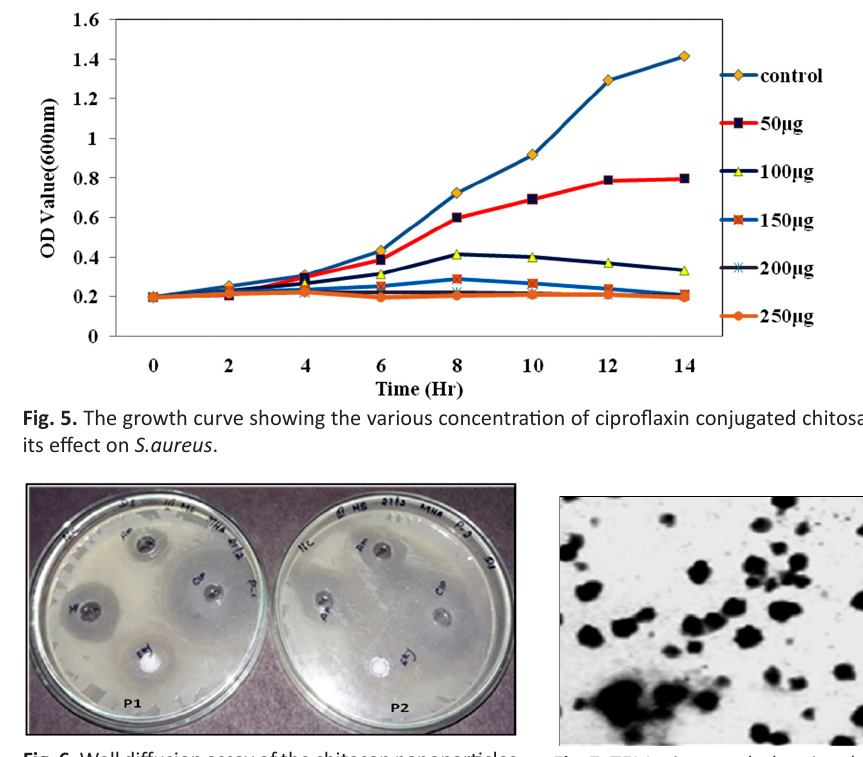
Fig. 7. TEM micrograph showing the size of the chitosan